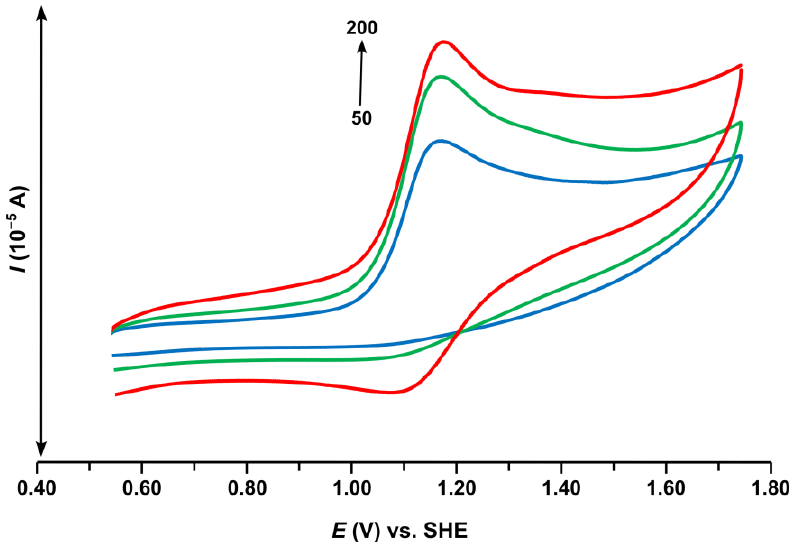
Figure 4. Cyclic voltammograms of L ( c ≈ 1 mM) recorded under an argon atmosphere in 0.1 M TBAP acetonitrile solution with a glassy carbon working electrode at the scan rates of 200 (red), 100 (green), and 50 mV/s (blue).